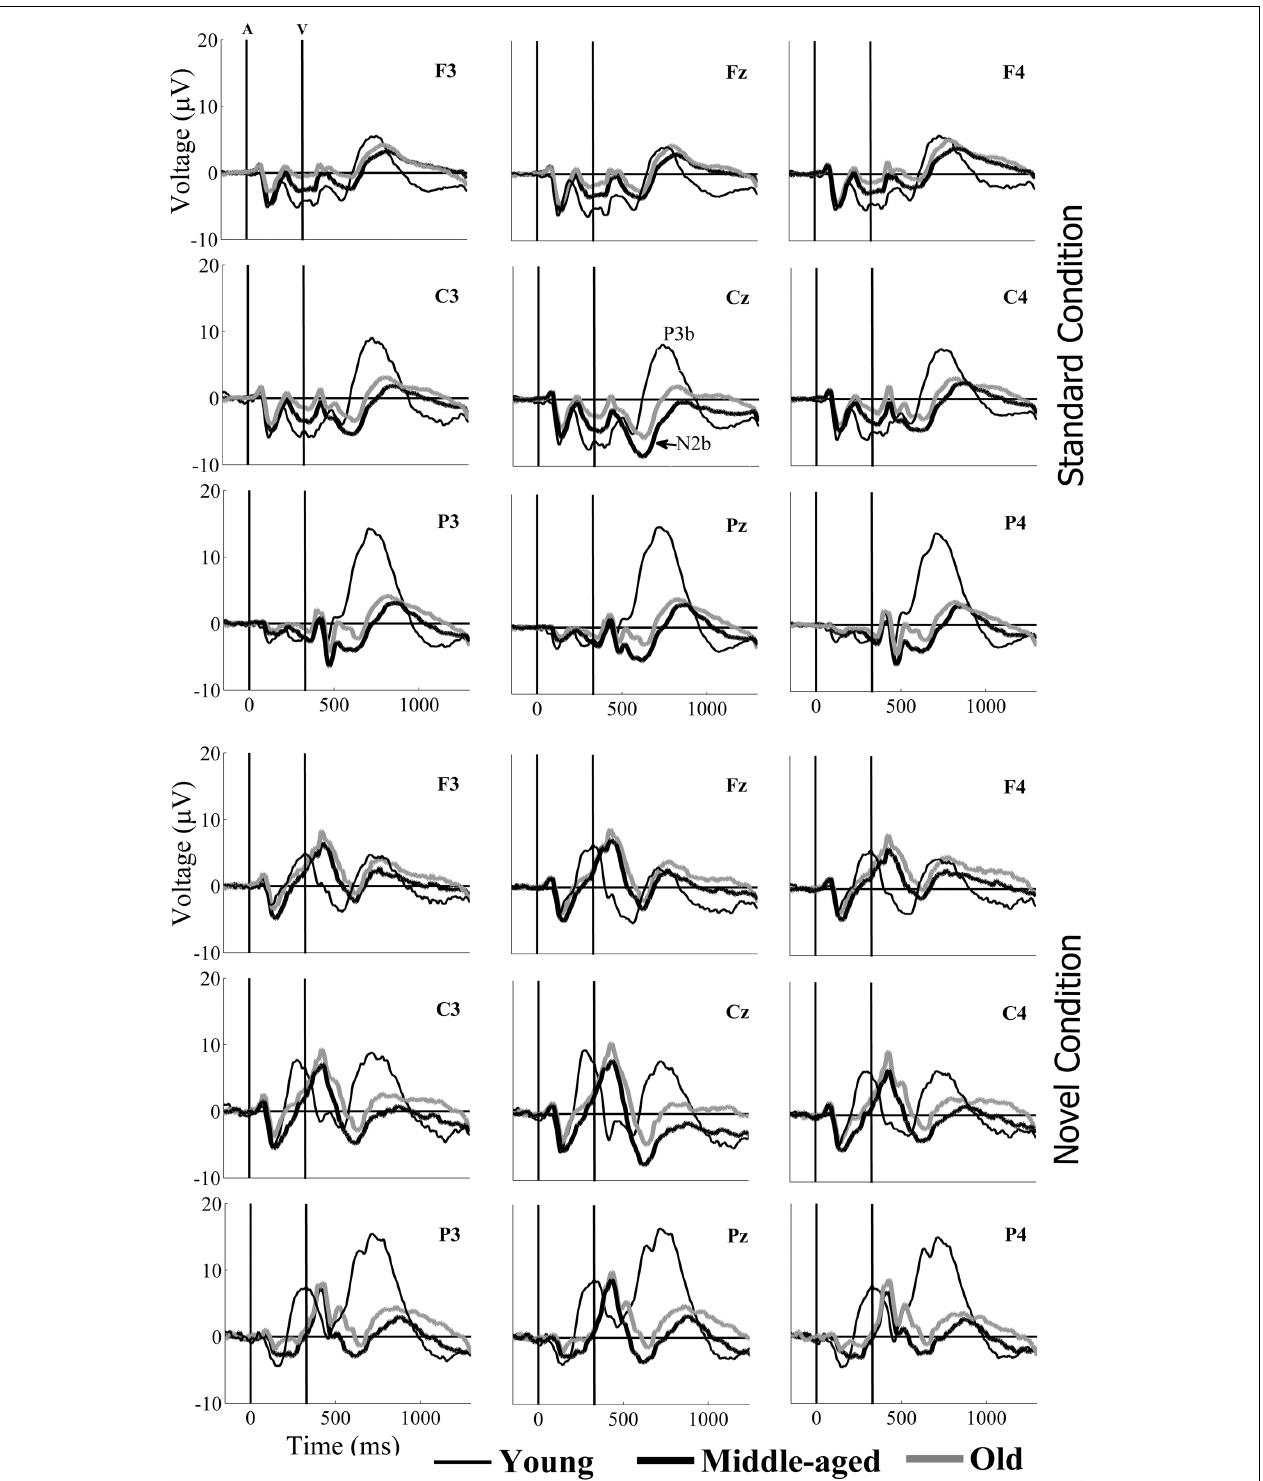
FIGURE 2 | Grand-average event-related potential waveforms, for the Young (thin black line), Middle-aged (thick black line), and Old (thick gray line) groups, in the standard (upper pannel) and the novel (lower pannel) conditions, at F3, Fz, F4, C3, Cz, C4, P3, Pz, and P4 electrode